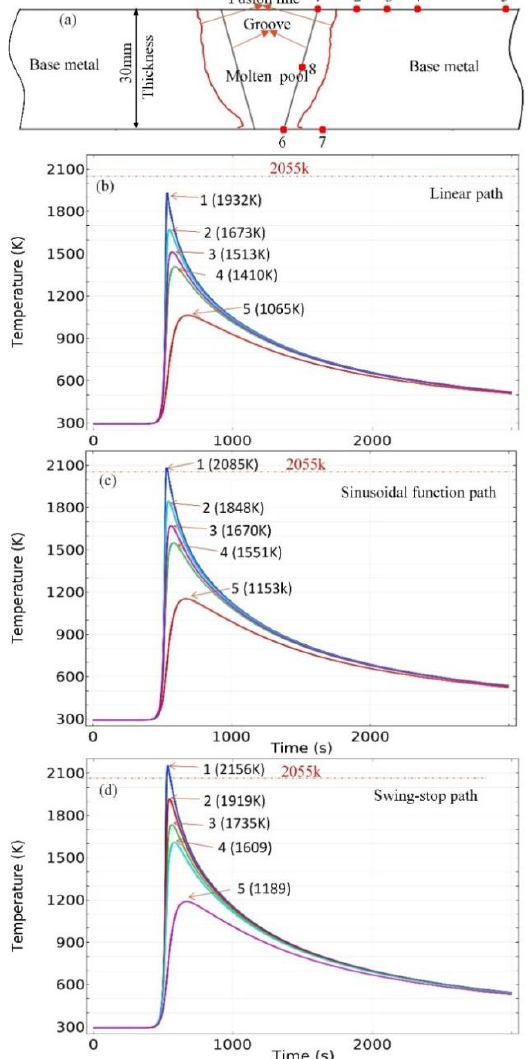
Figure 11. Calculated thermal cycles at selected points in heat affect zones (HAZ), ( a ) position of selected points in HAZ, ( b ) thermal cycle curves using linear path, ( c ) thermal cycle curves using sinusoidal path, ( d ) thermal cycle curves using oscillate-stop path. Table 8. The peak temperature of selected point as shown in Figure 8.